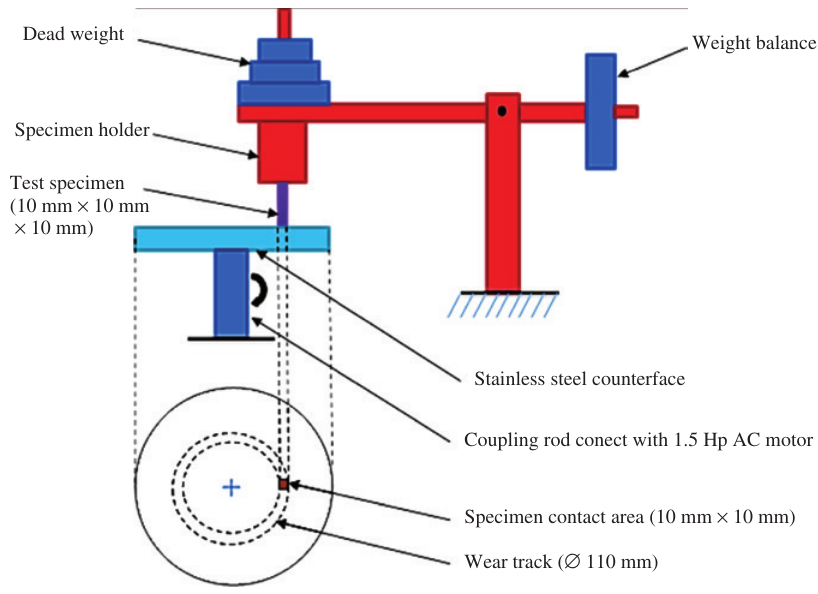
Figure 5: Schematic diagram of POD machine with test